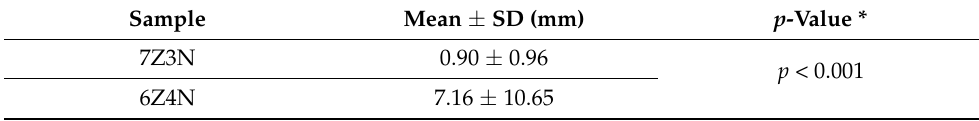
Table 1. Marginal discrepancy of samples 7Z3N and 6Z4N sintered at 1350 ◦ C for 4 h (N = 36).